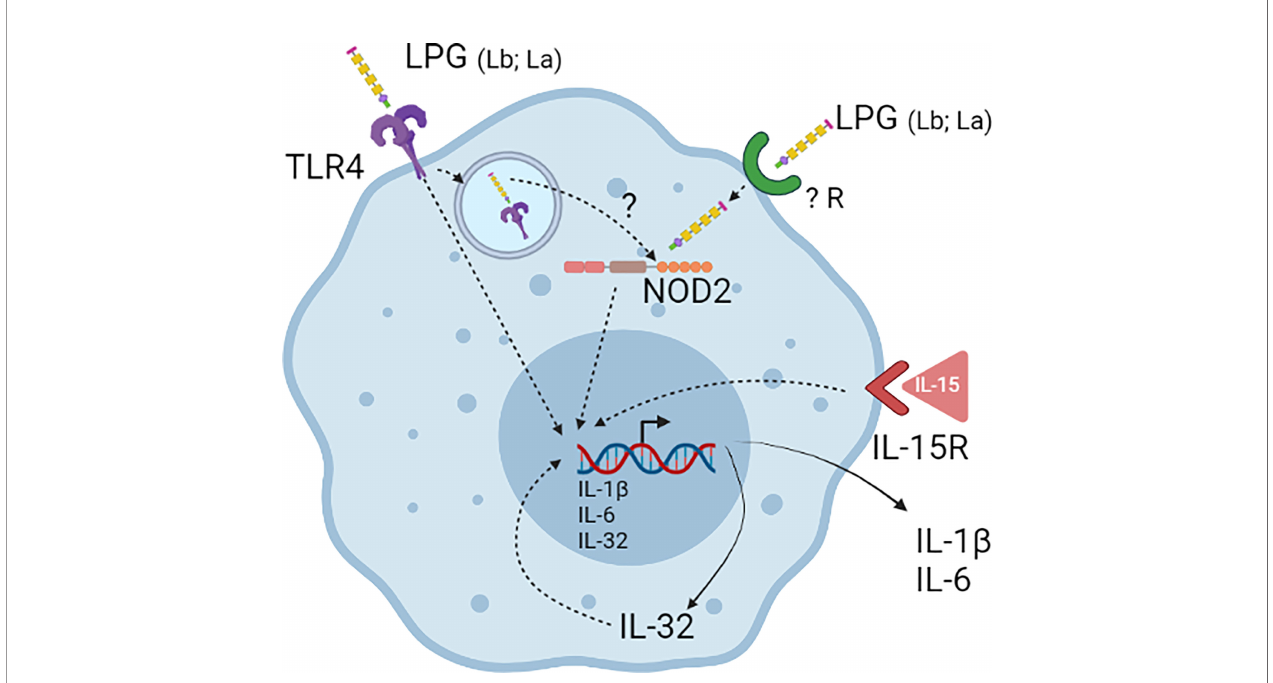
FIGURE 7 | Lipophosphoglycans (LPGs) from L. amazonensis and L. braziliensis are molecules responsible for inducing IL-32 production. LPGs induce IL-32 in a TLR4- and NOD2-dependent manner in human PBMCs. After LPG endocytosis by TLR4 it can escape the endosomes and activate NOD2. IL-32 can increase the production of pro-in fl ammatory cytokines such as IL-6 and IL-1 b induced by